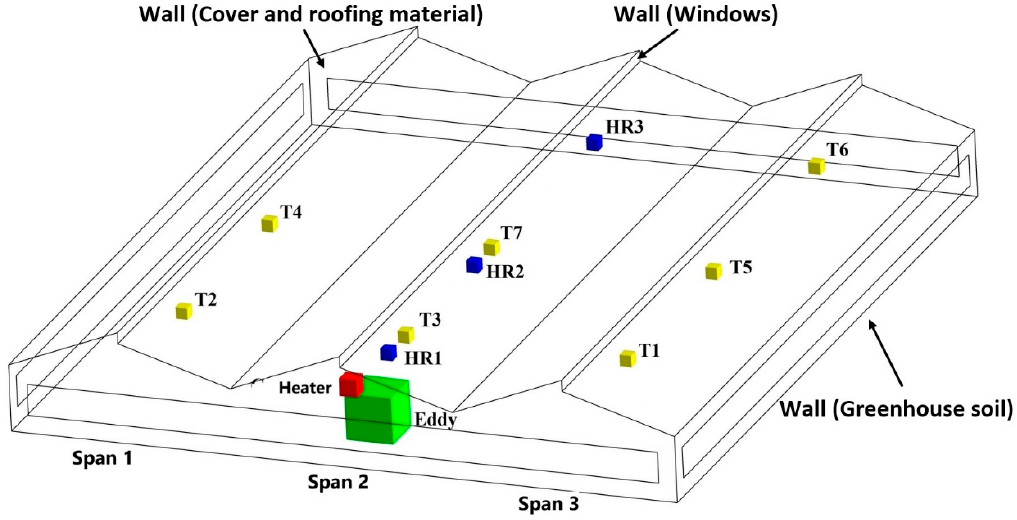
Figure 1. Distribution of the temperature ( ⬛ ) and humidity ( ⬛ ) sensors, the heater ( ⬛ ), and the Eddy Covariance System ( ⬛ ) in the three buildings of the experimental greenhouse; border conditions of the computational model.